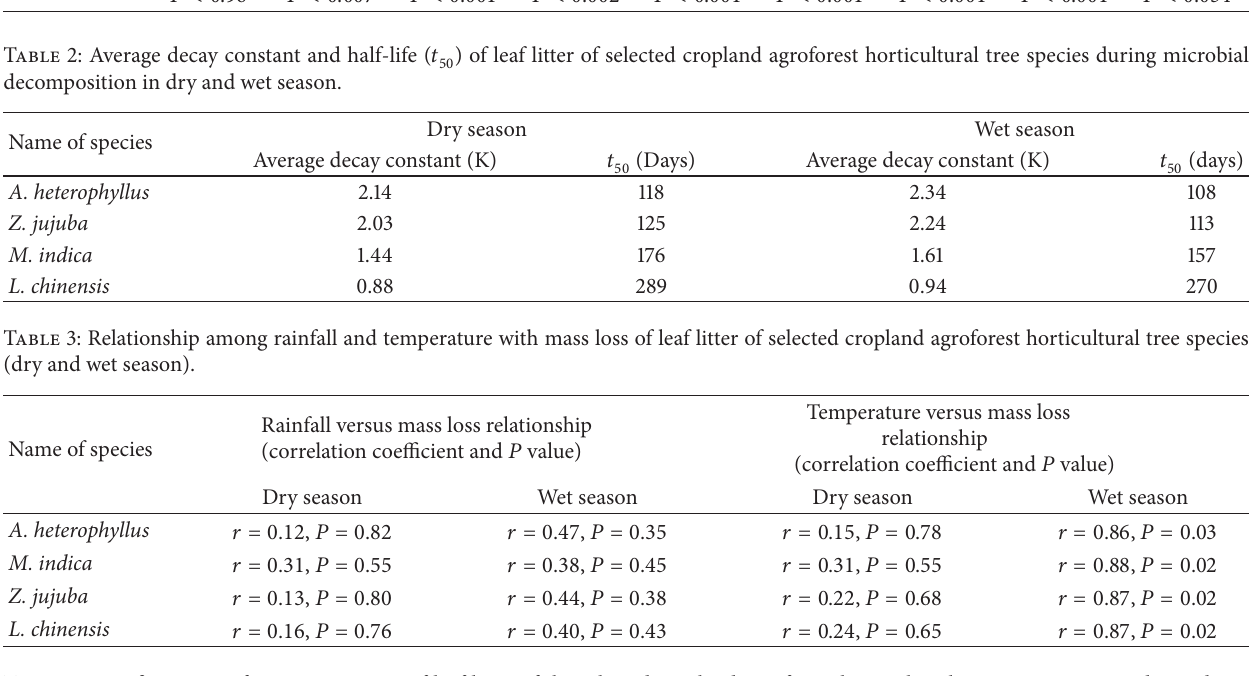
Table 4: Significant test of N concentration of leaf litter of the selected cropland agroforest horticultural tree species among dry and wet season.